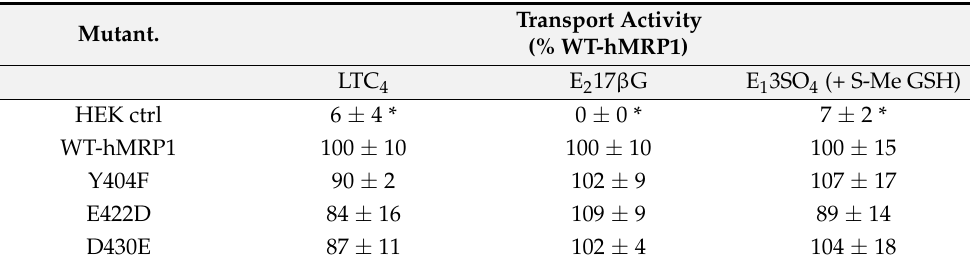
Table 2. Effect of conservative substitutions of CL4 residues outside the coupling helix on organic anion transport by hMRP1. Transport activity was measured as ATP-dependent uptake of [ 3 H]LTC 4 , [ 3 H]E 2 17 β G and [ 3 H]E 1 3SO 4 (in the presence of 3 mM S-methyl GSH (S-Me GSH)) into inside-out membrane vesicles prepared from transfected cells and expressed as a percent of wild-type (WT) hMRP1 uptake. The values shown have been adjusted to take into account minor differences in mutant hMRP1 levels in the membrane vesicles relative to wild-type MRP1. Values shown represent the means ( ± SD) of results obtained from three independent experiments. Transport Activity Mutant. (%